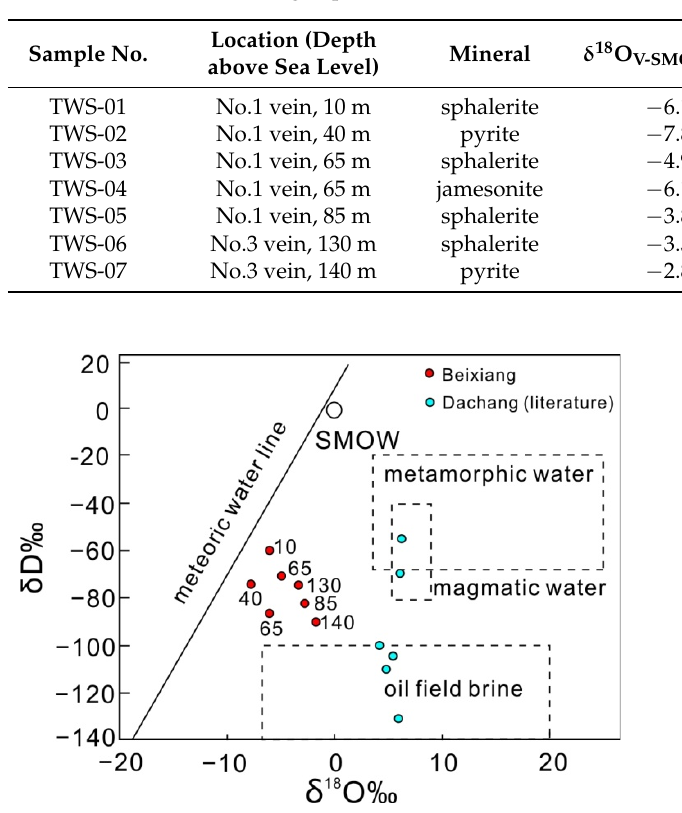
Figure 5. Plot of fluid inclusion H ‐ O isotopes of sulfides from the Beixiang stage II ores. Data near the composition point indicate the sample elevation (meter) above sea level. Table 2. Hydrogen and oxygen isotopic compositions of fluid inclusions from second ‐ stage miner ‐ alization sulfide in the Beixiang deposit.